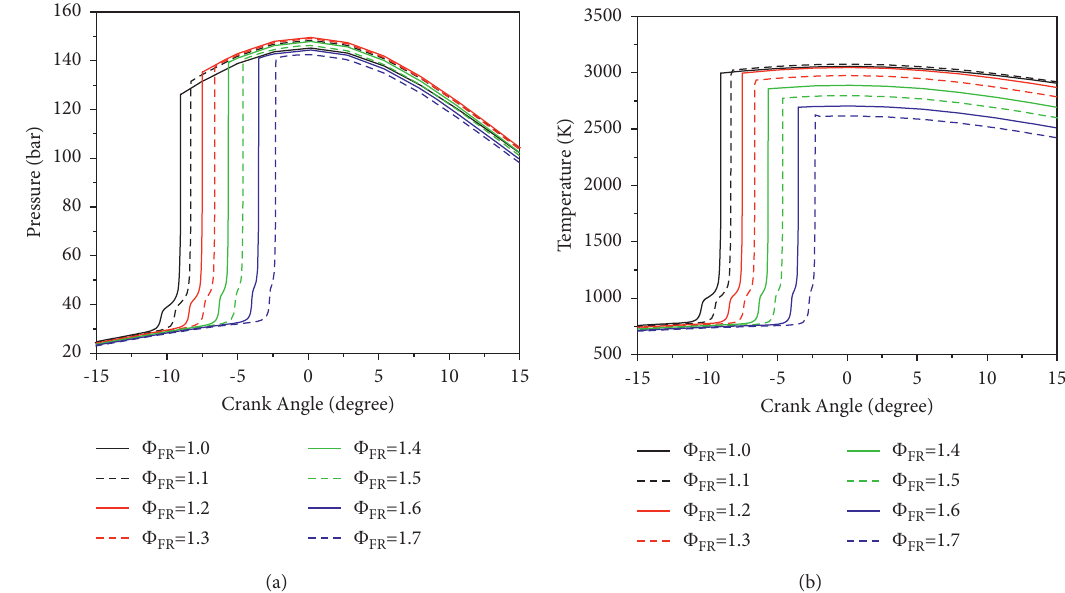
Figure 2: Pressure and temperature profiles of the reforming cylinder at different n-heptane equivalence